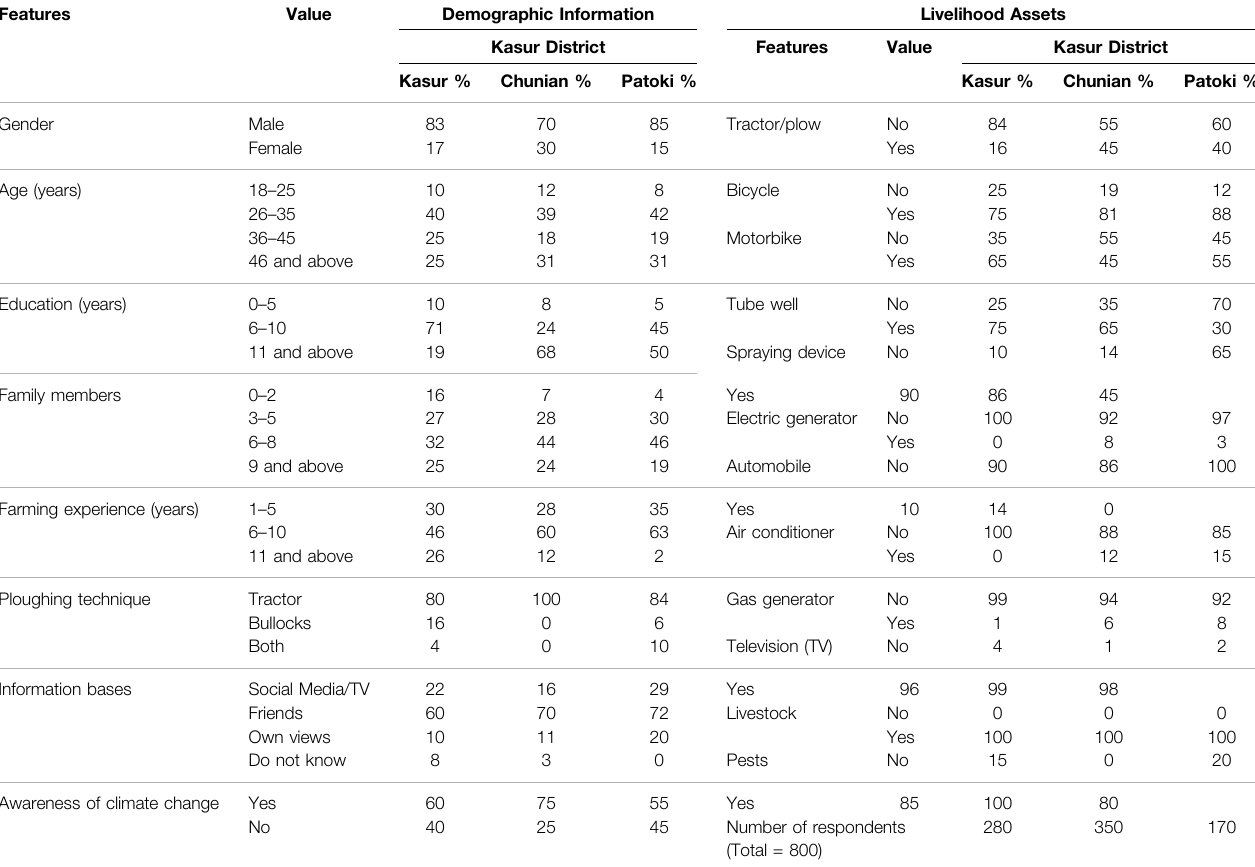
TABLE 1 | Demographic information/livelihood assets of agricultural communities.